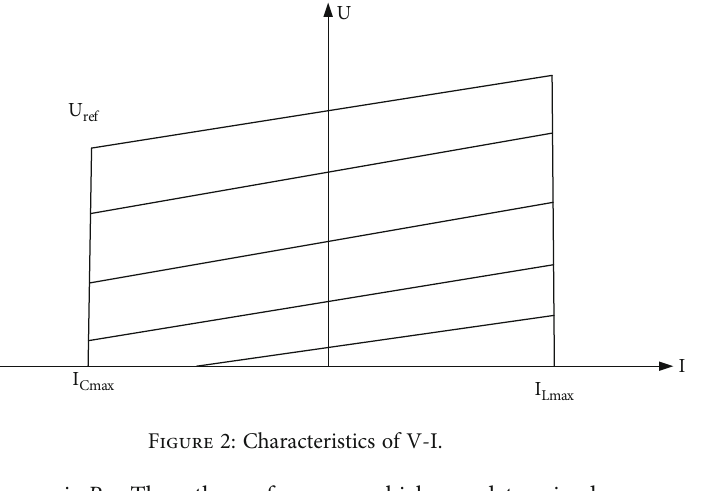
Figure 2: Characteristics of V-I.